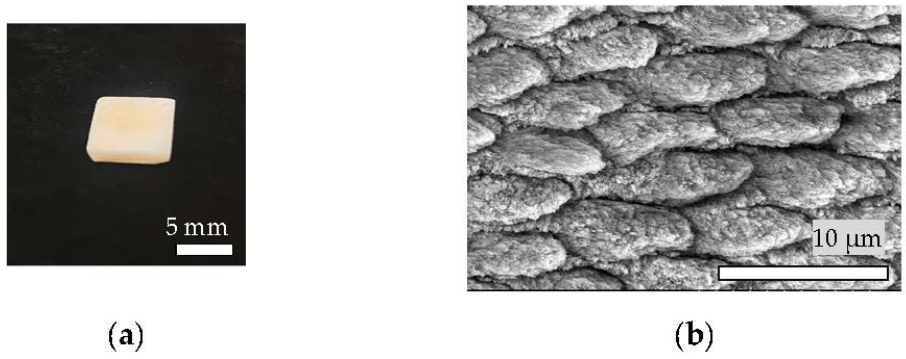
Figure 2. Gross appearance ( a ) and SEM images ( b ) of specimen (10 kV); the interspace of the decal ‐ cified bovine enamel prisms can be